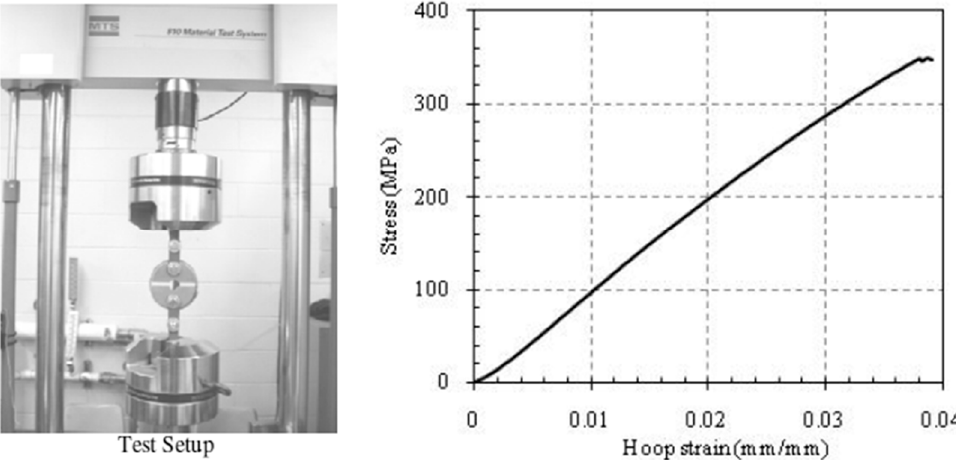
Figure 5. Test setup and stress-strain curve for the FRP tubes for coupon tensile test of Tube B [28].